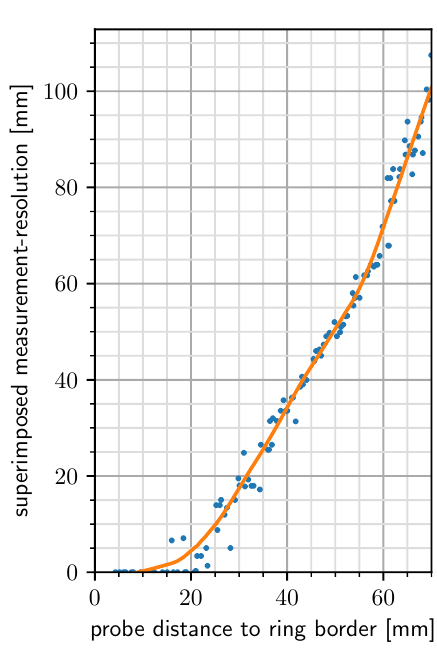
Figure 9. Spatial resolution at distances measured between ring-border and